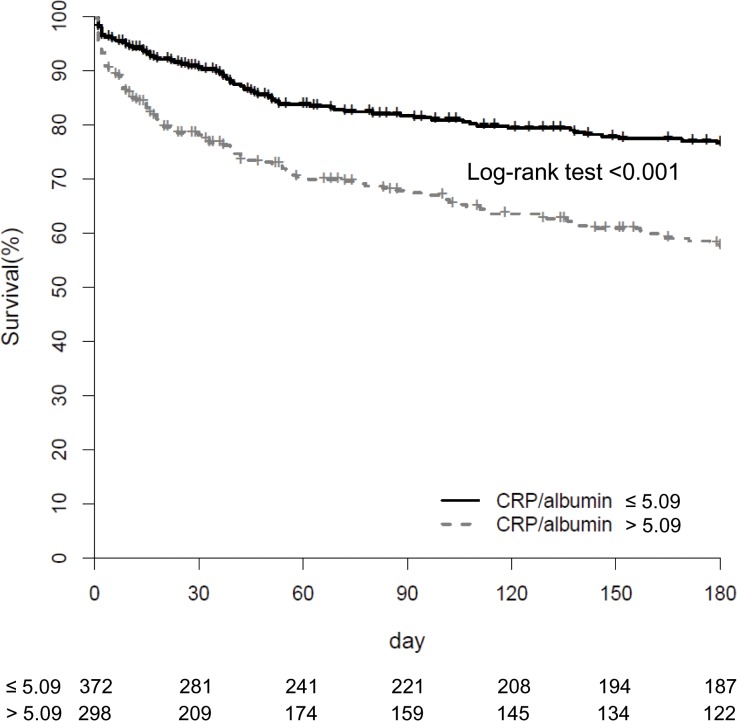
Kaplan-Meier analysis of the cumulative percentage of surviving patients at 180-days according to the different CRP/albumin levels.Patients with higher levels of CRP/albumin ratio had a reduced survival rate. Solid line, CRP/albumin ratio ≤5.09; dashed line, CRP/albumin ratio >5.09.